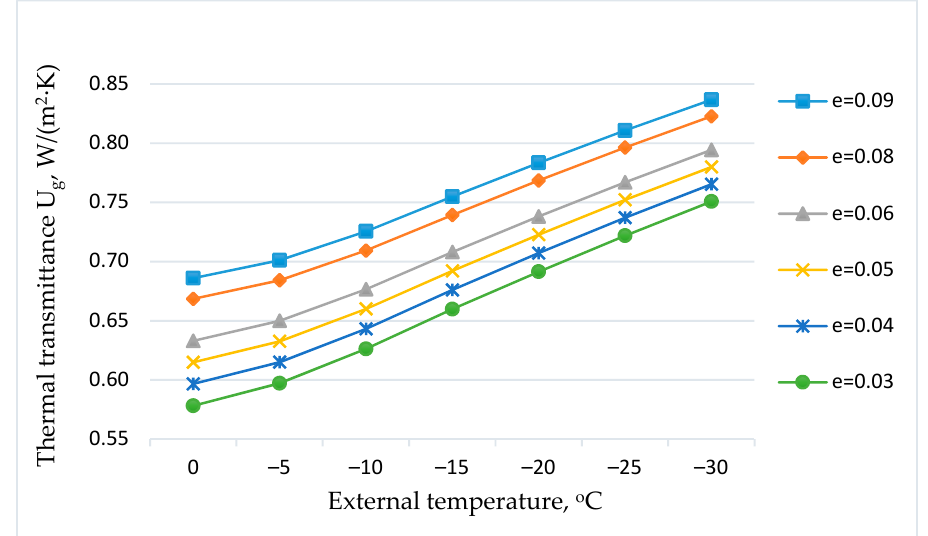
Figure 6. Dependence of the U g -values of the triple-glazed IGU on the Low-E coating value and external air temperature.